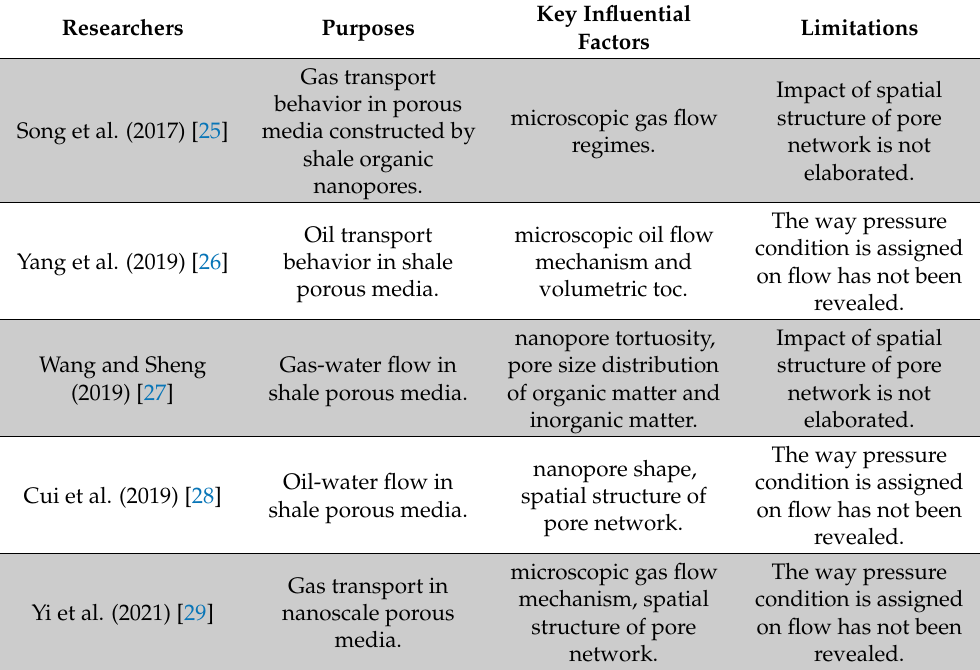
Table 1. Literature review of recent main research about gas phase PNM. Researchers Purposes Song et al. (2017) [25]